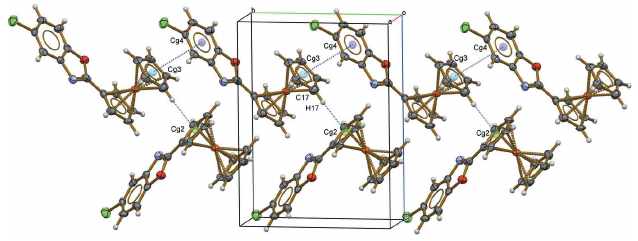
Figure 2 Crystal packing of 5-chloro-2-ferrocenylbenzo[ d ]oxazole showing the short contacts of type (cid:2) – (cid:2) and C—H (cid:3)(cid:3)(cid:3) (cid:2) .